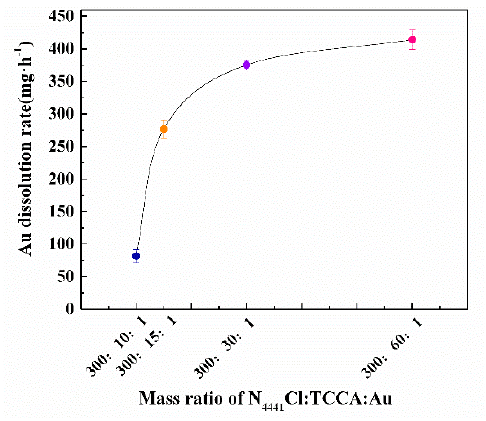
Figure 7. Effect of N 4441 Cl and TCCA ratio on dissolution rate.